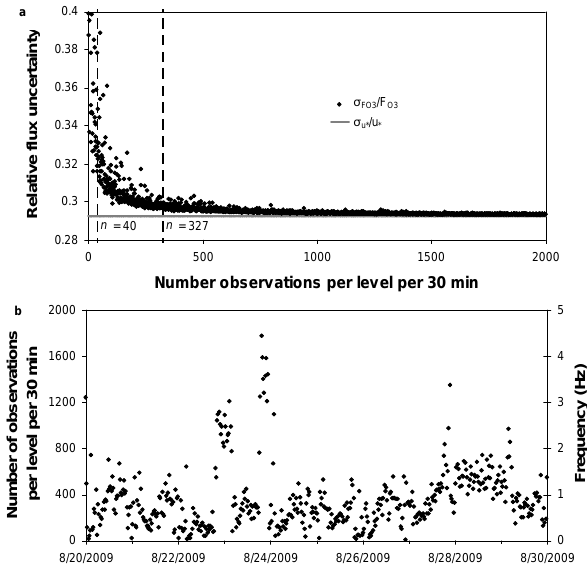
Fig. 8. (a) Relative flux uncertainty for the aerodynamic gradient Figure 8: (a) Relative flux uncertainty for the aerodynamic gradient method as a function method as a function of the number of mixing ratio data available of the number of mixing ratio data available per level per 30 min. Example of the O 3 flux per level per 30min. Example of the O 3 flux the 25 August 2009 the 25 August 2009 from 15h30 to 16h00. The number of points available from from 15:30 to 16:00. The number of points available from measure- measurements using the fast response sensor (n = 327) and under the hypothesis of the ments using the fast response sensor ( n = 327) and under the hy- use of slow response sensor (n = 40) are indicated on the figure with the dashed line. (b) pothesis of the use of slow response sensor ( n = 40) are indicated Time series of number of mixing ratio points used to estimate the mean mixing ratio at on the figure with the dashed line. (b) Time series of number of mix- each level per 30 min based on the frequency corresponding to the inverse of the integral ing ratio points used to estimate the mean mixing ratio at each level time scale of turbulence. This frequency corresponds to the maximum frequency above per 30min based on the frequency corresponding to the inverse of which the data are not independent and should not contribute to diminish the standard the integral time scale of turbulence. This frequency corresponds deviation as shown in (a). to the maximum frequency above which the data are not indepen- dent and should not contribute to diminish the standard deviation as shown in (a)